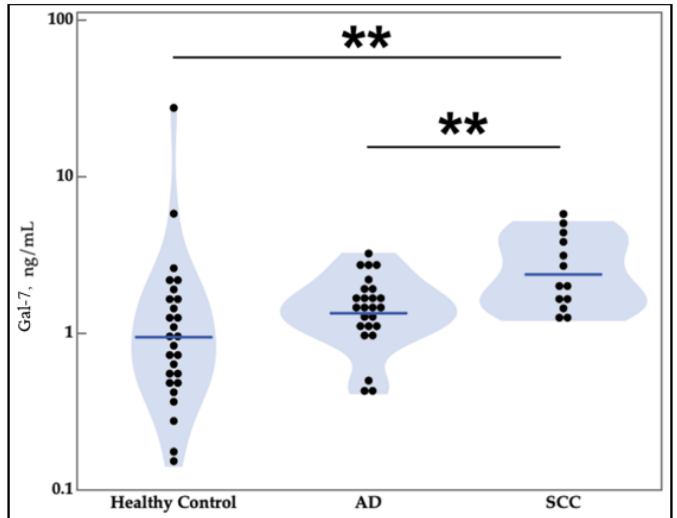
Figure 3. Lung squamous cell carcinoma patients have increased serum levels of galectin-7 relative to lung adenocarcinoma patients. AD is adenocarcinoma. SCC is squamous cell carcinoma. Cancer galectin levels were determined by ELISA of patient serum samples. SCC and healthy control comparison was made using nonparametric comparison with control using the Steel method. SCC and AD comparison was made using the Wilcoxon test (** p ≤ 0.01). Gal = galectin.